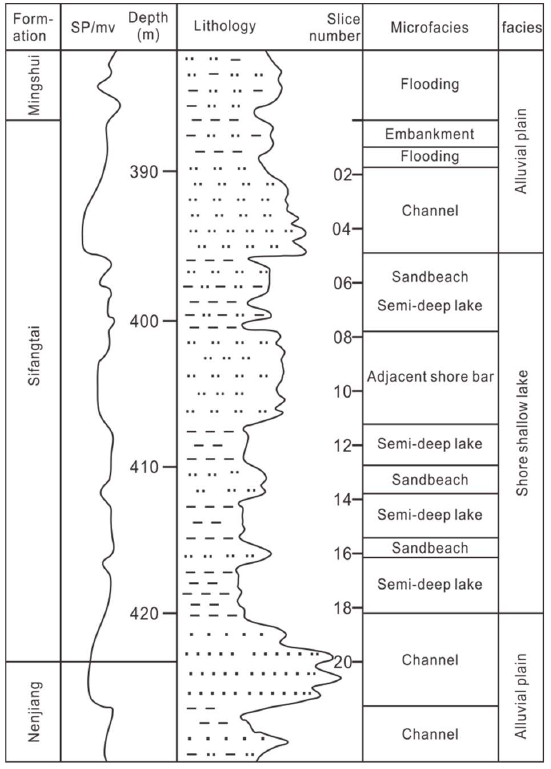
Figure 10. Sedimentary evolution in well 58. It is modified from Chen et al. in 2013